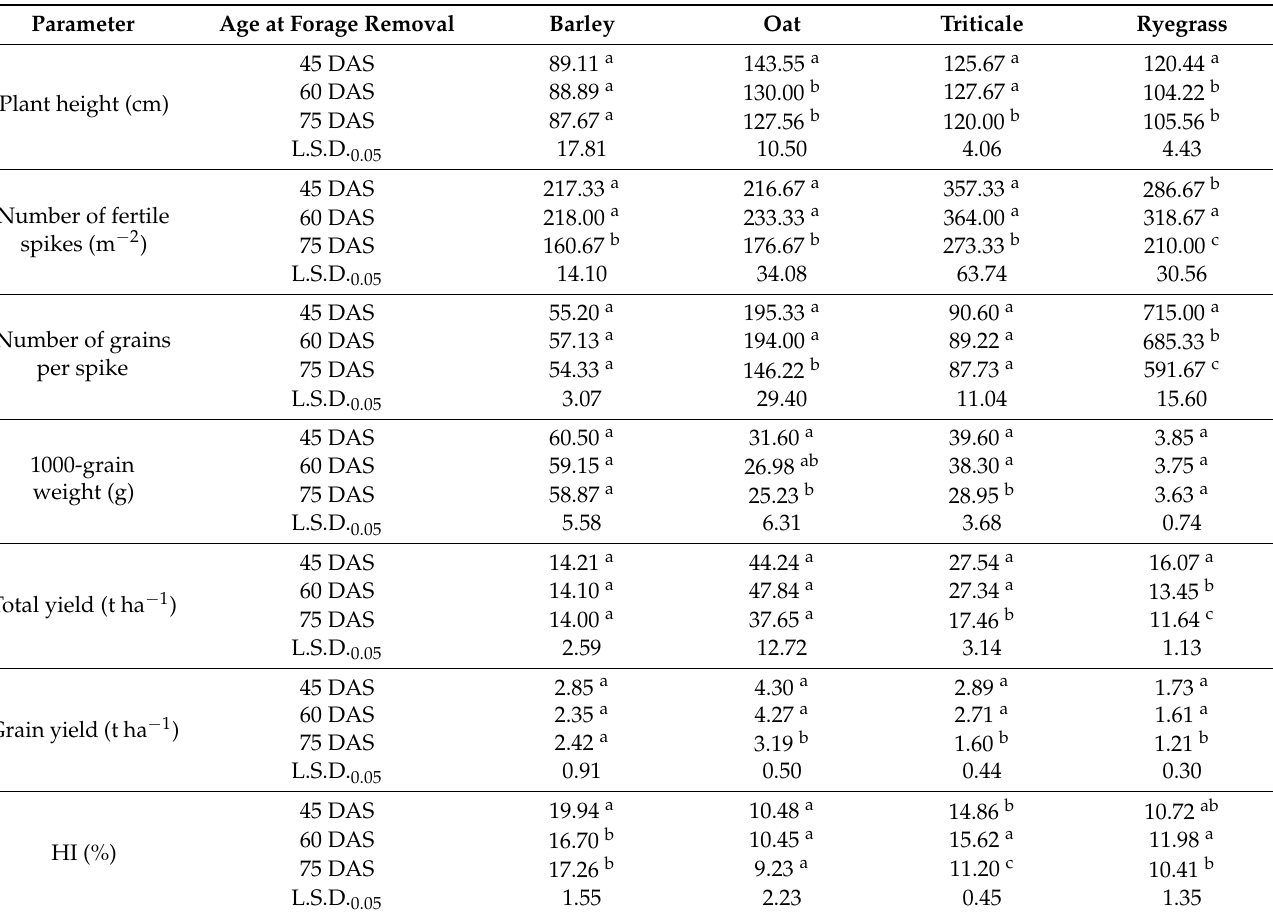
Table 2. Means of agronomic parameters, total and grain yields, and harvest index (HI) of the four crops as affected by the age at forage removal (DAS).